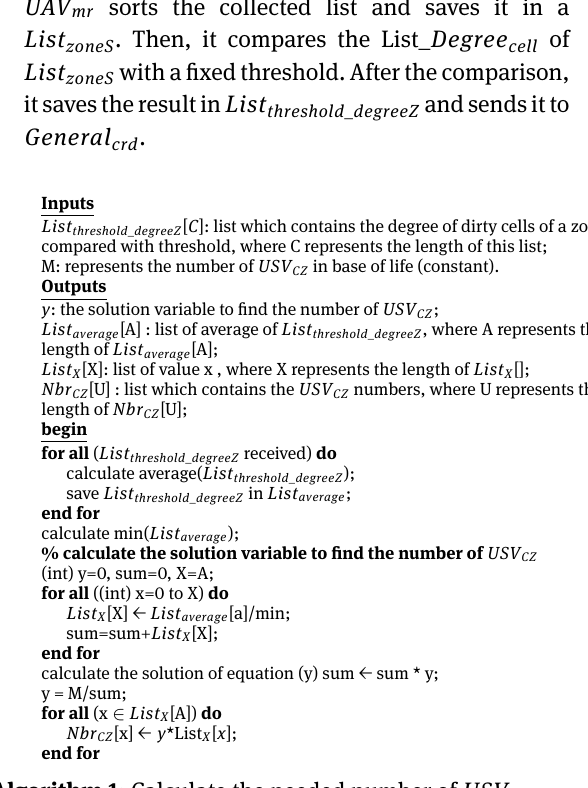
Algorithm 1: Calculate the needed number of USV CZ